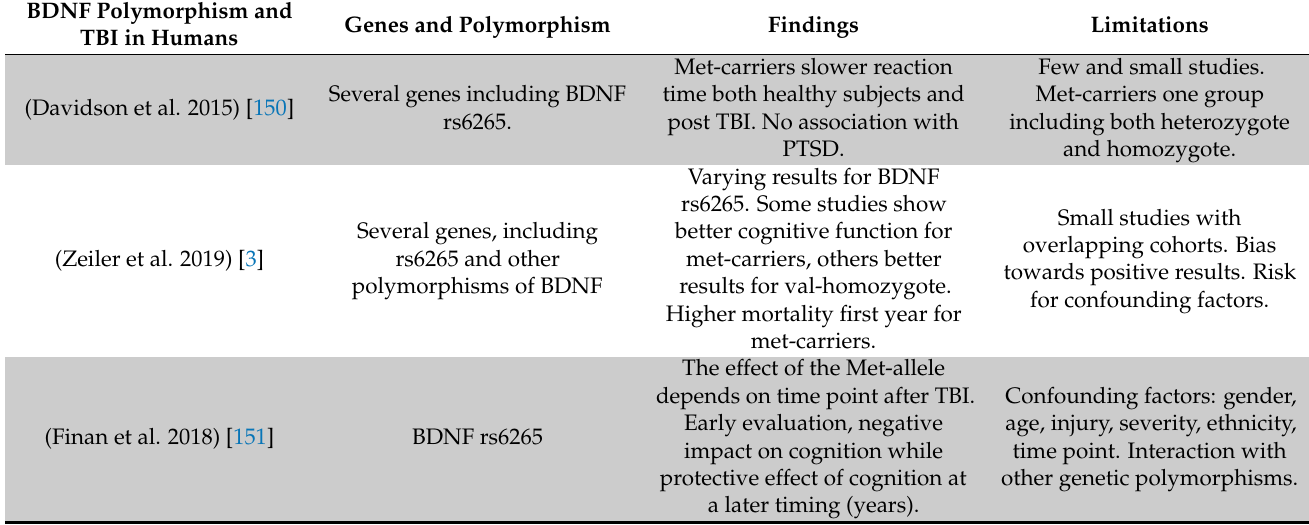
Table A3. Overview of the reviewed studies examining BDNF polymorphism in humans and a short summary of their reported